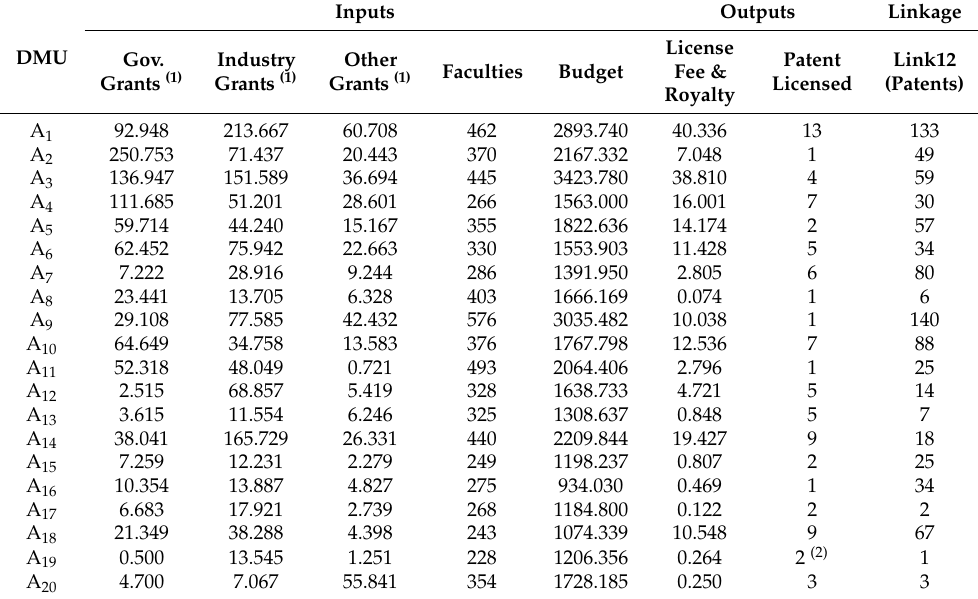
Table 7. The original data of inputs, outputs and linkages (as of the year